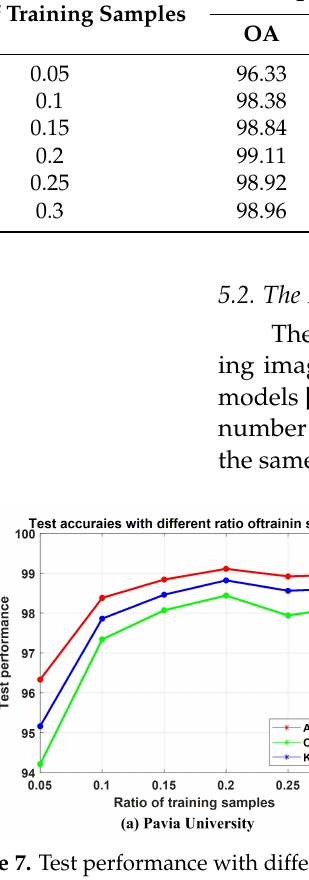
Table 6. Test accuracies of different partition of training Samples on Pavia Center, Pavia University, and KSC datasets. Pavia Univ./(%) KSC/(%) Salinas (%) Ratio of Training Samples OA